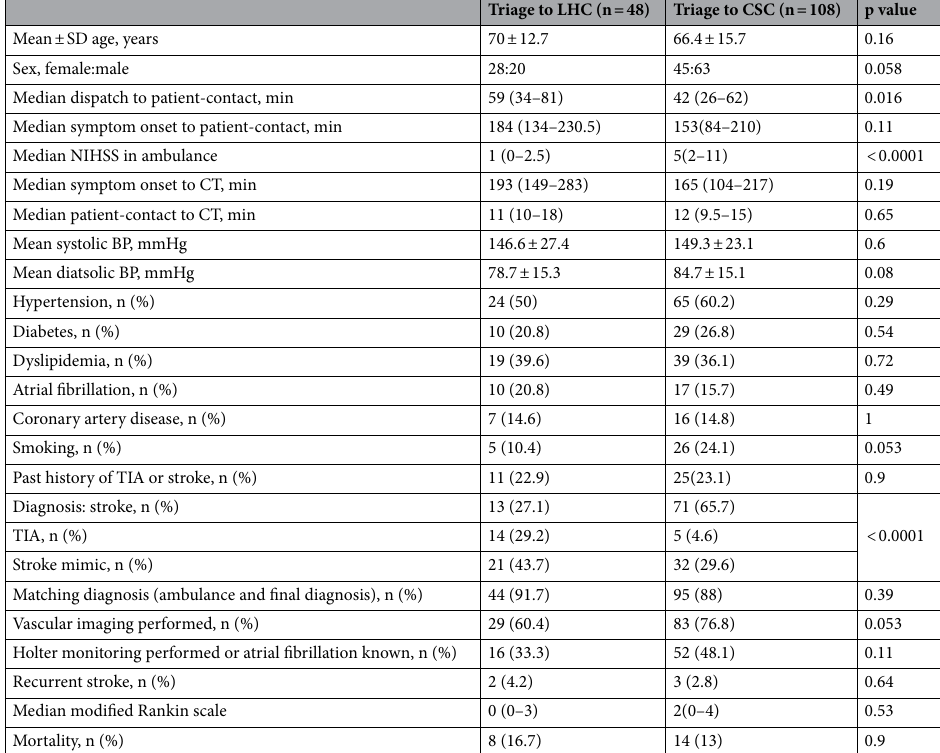
Table 1. Characteristics of acute stroke syndrome patients evaluated in the mobile stroke unit in triage to local hospital care and triage to comprehensive stroke centre